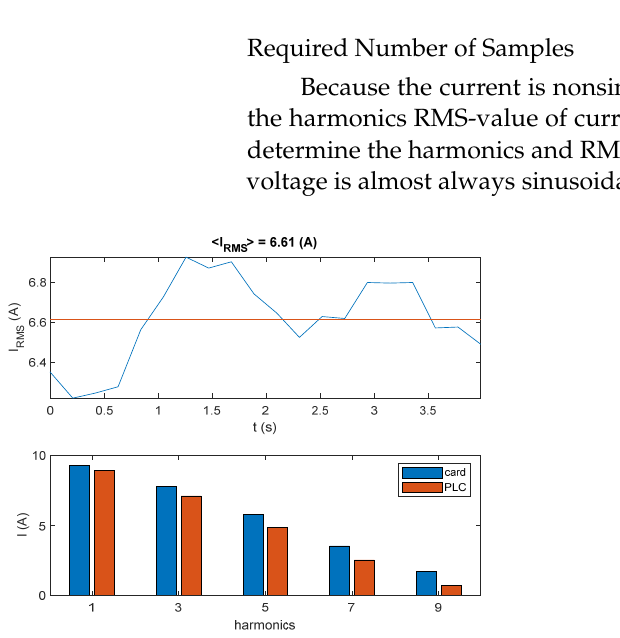
Figure 12. The two-point vs. three-point measurement method of U RMS value. The resulting active power calculated based on the first harmonic (22) is depicted below in Figure 13.